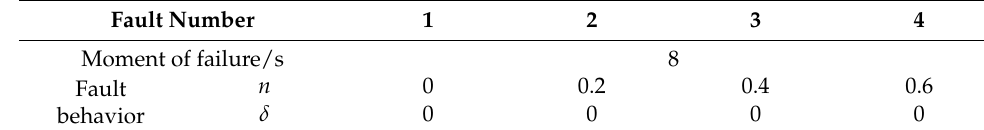
Table 3. Description of fault behavior.